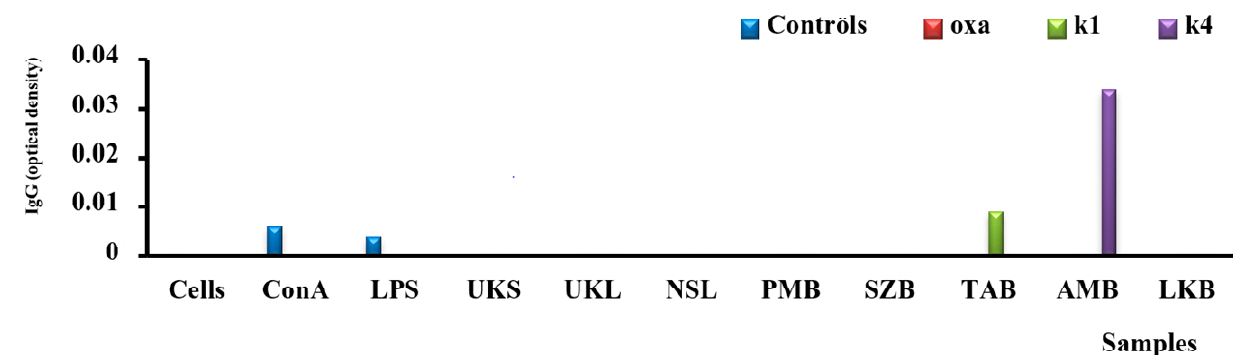
Figure 7. Illustration of the induction of IgG with polysaccharide extracts: oxalate (oxa), KOH 1 M (k1) and 4 M (k4) compared with concanavalin A (ConA), lipopolysaccharides (LPS) and unstimulated